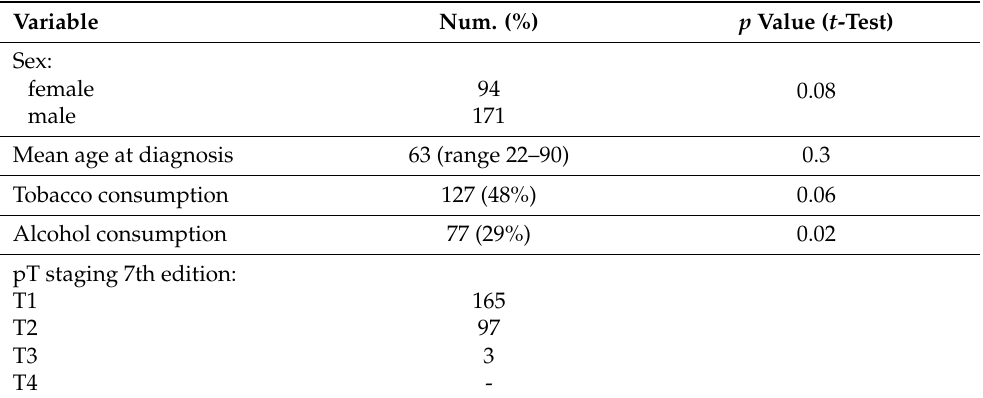
Table 1. Univariate analysis of the study